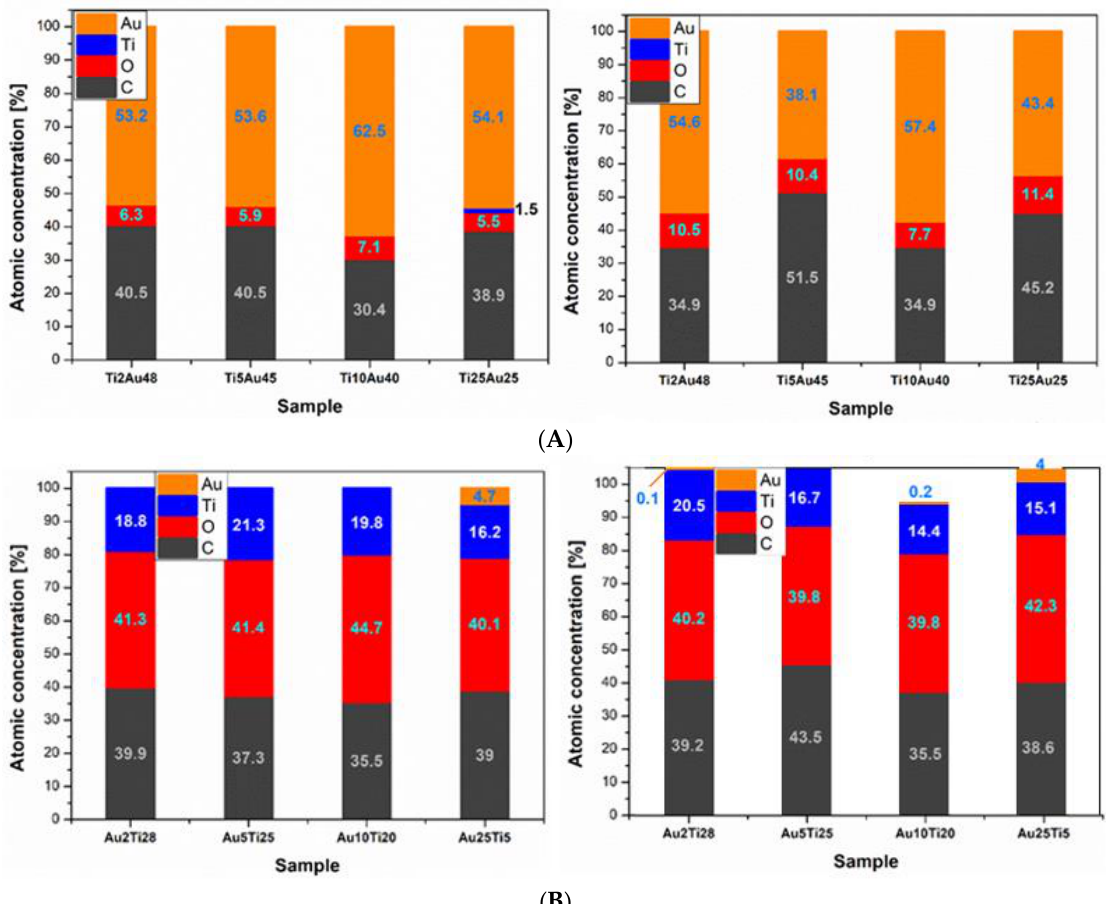
Figure 8. The concentration of the individual elements contained in the surface layer of the samples with the lower layer of titanium and the upper layer of gold obtained by XPS. ( A ) The results for samples with titanium bottom layer and gold upper layer before and after the heating process. ( B ) The results of the samples with the gold bottom layer and the titanium upper layer before and after the heating process. Unheated samples on the left, samples after heating on the right.